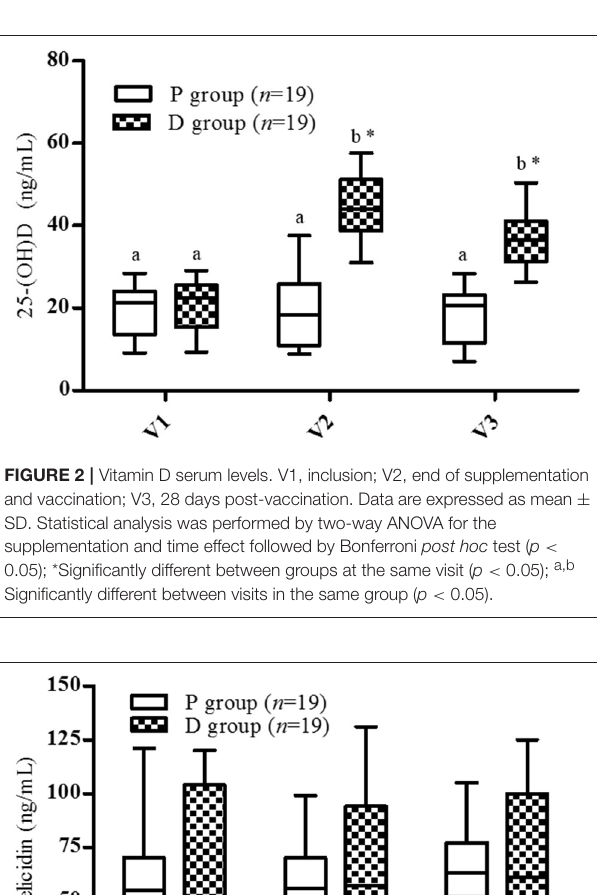
between cathelicidin and 25-(OH)D serum levels was observed ( r = – 0.10, p = 0.53, Figure 4B